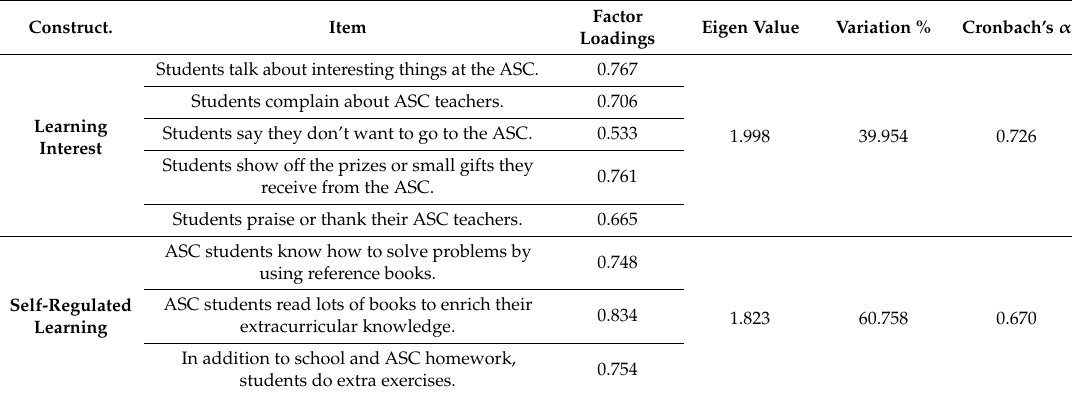
Table 1. Factor loadings and reliability